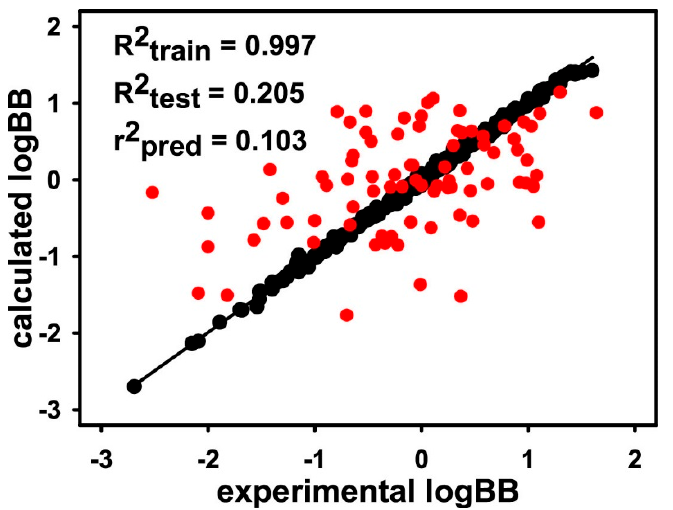
Figure 4. Linear diagram showing correlation between the experimental and calculated LogBB val- ues for a total of 406 molecules in the whole dataset. Indicated in black and red circles are the molecules in the training and test sets, respectively.